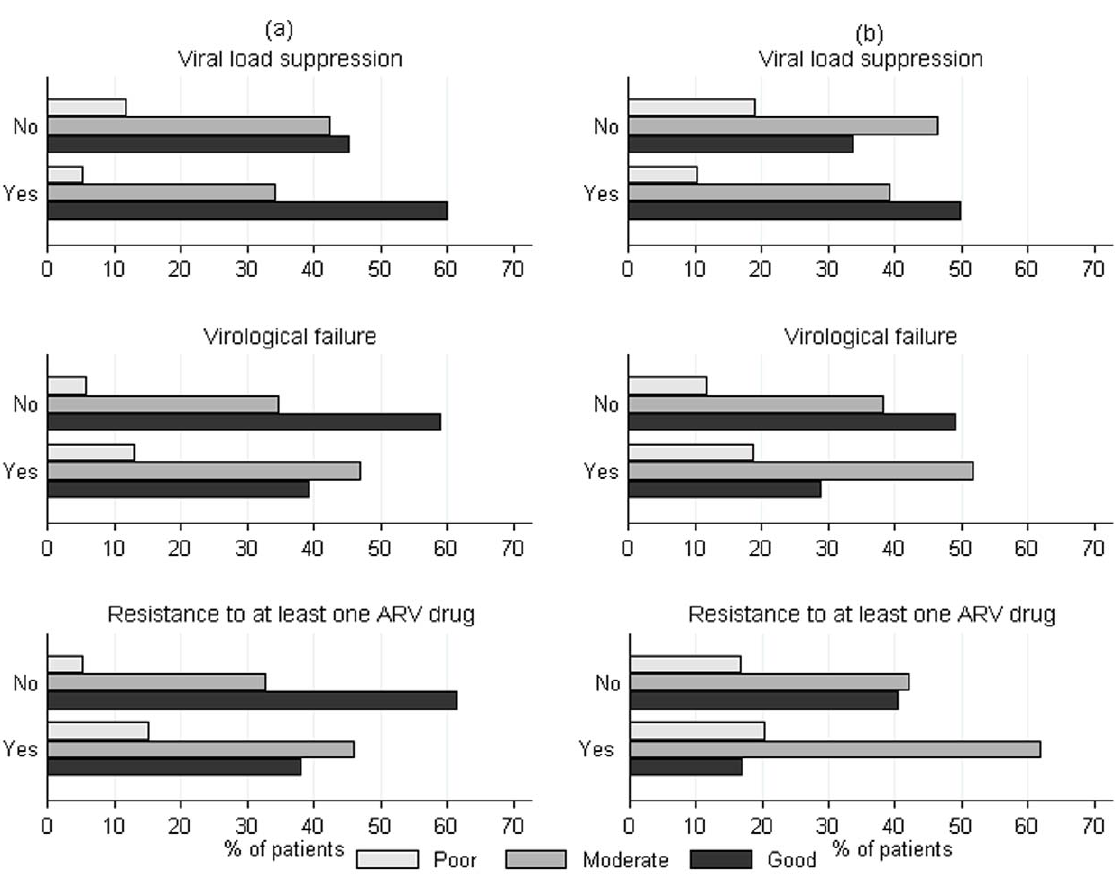
Figure 3. Patient distribution of adherence to clinic visits by outcome in adults (a) and children (b).